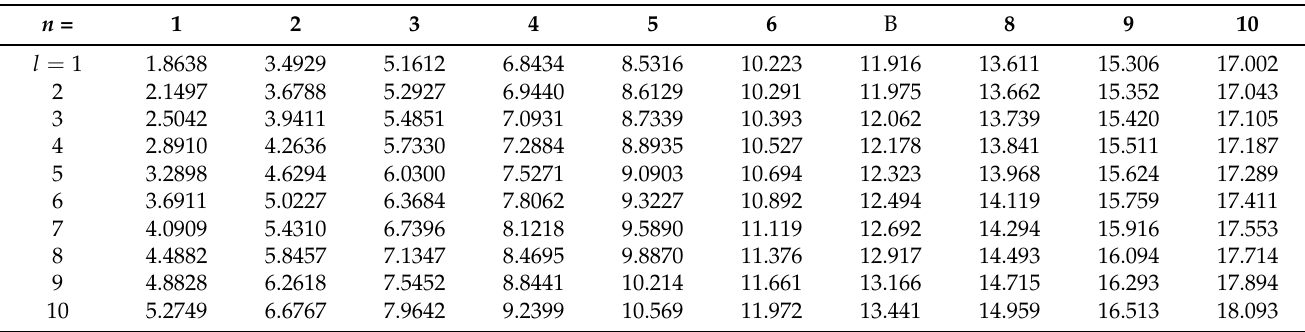
Table 1. Values for k ln , g l ( k ln ) = 0, for l , n = 1, . . .